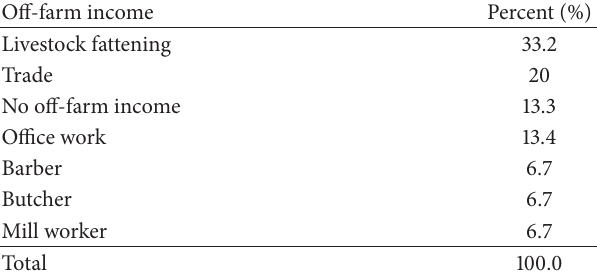
Table 3: Off-farm income characteristics of respondents ( 𝑁 = 90